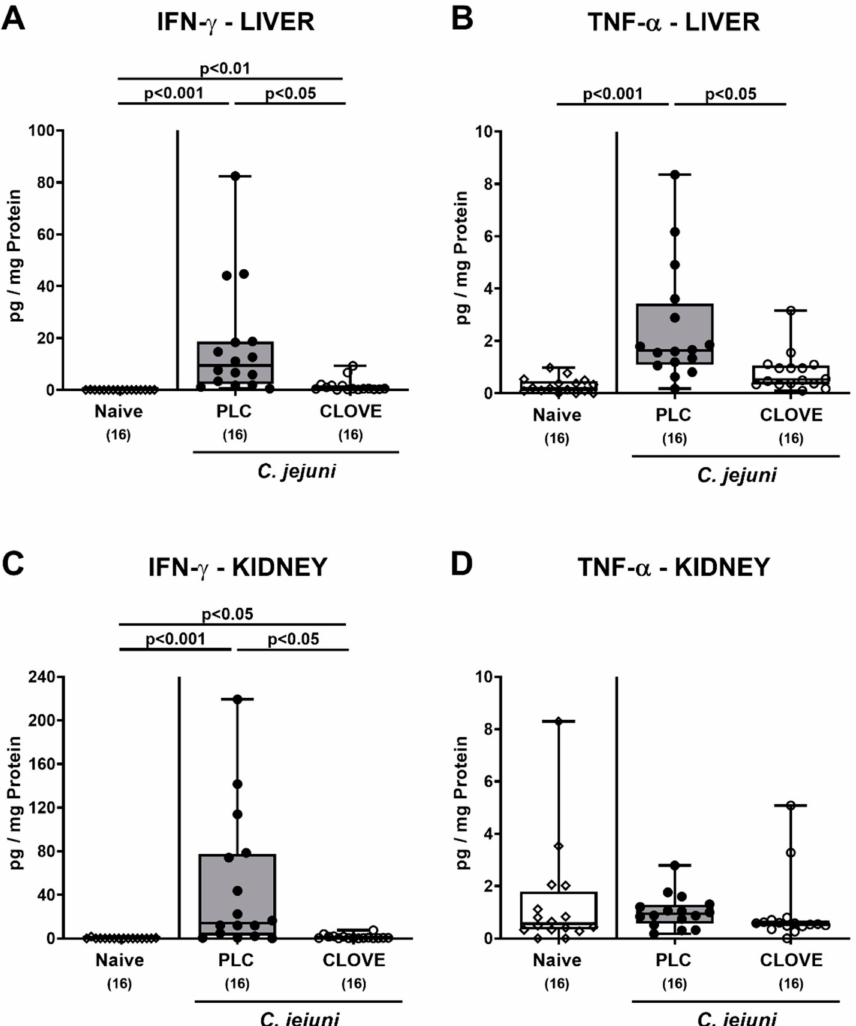
Figure 7. C. jejuni induced extra-intestinal proinflammatory cytokine secretion following clove EO treatment of infected IL-10 − / − mice. Microbiota-depleted IL-10 − / − mice were perorally infected with C. jejuni strain 81-176 on day (d) 0 and d1. From d2 until d6 post-infection (p.i.), mice were perorally challenged with clove EO or received placebo (PLC) via drinking water. On day 6 p.i., ( A , C ) IFN- γ and ( B , D ) TNF- α concentrations were measured in ex vivo biopsies derived from the ( A , B ) liver and ( C , D ) kidneys. Box plots indicate the 75th and the 25th percentiles of the median (black bar within box). Naive mice were included as negative control animals. The total range, significance levels ( p values) determined by the Kruskal-Wallis test and Dunn’s post-correction and the total numbers of analyzed mice (in parentheses) are given. Data were pooled from four independent